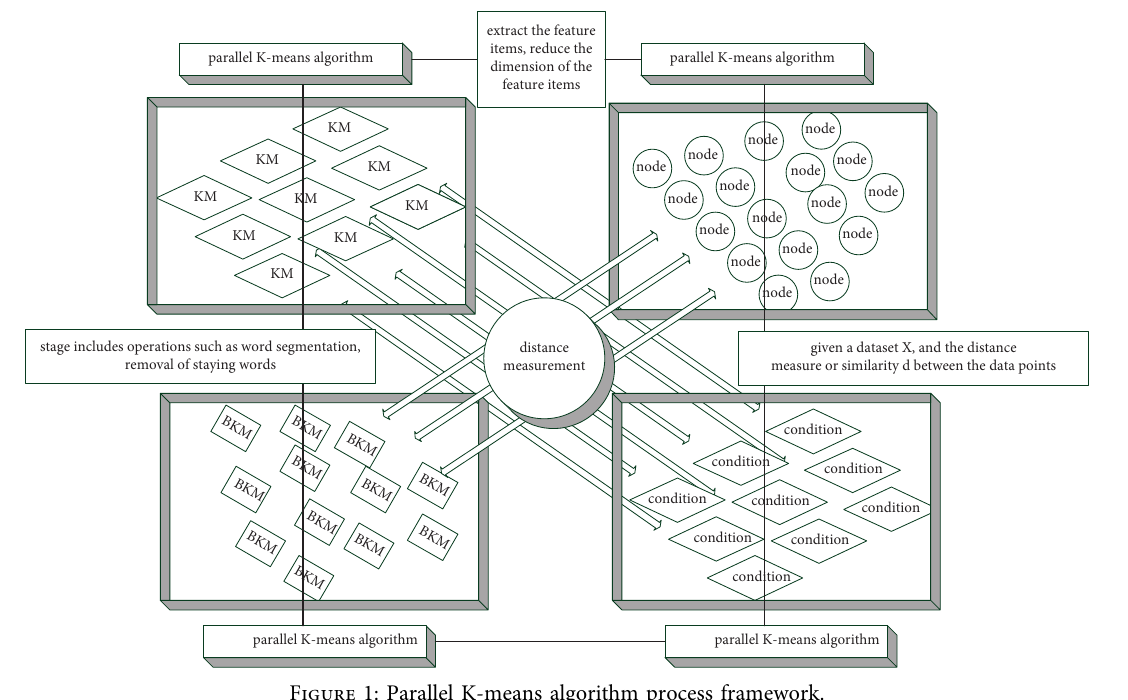
Figure 1: Parallel K-means algorithm process